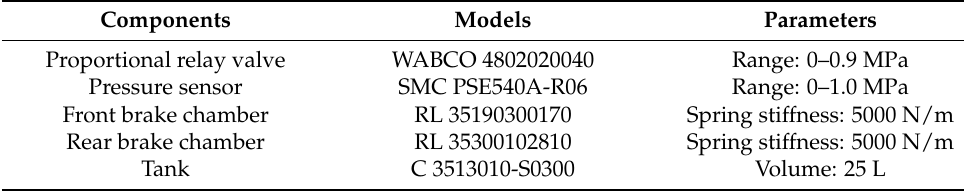
Table 3. Components of pneumatic braking